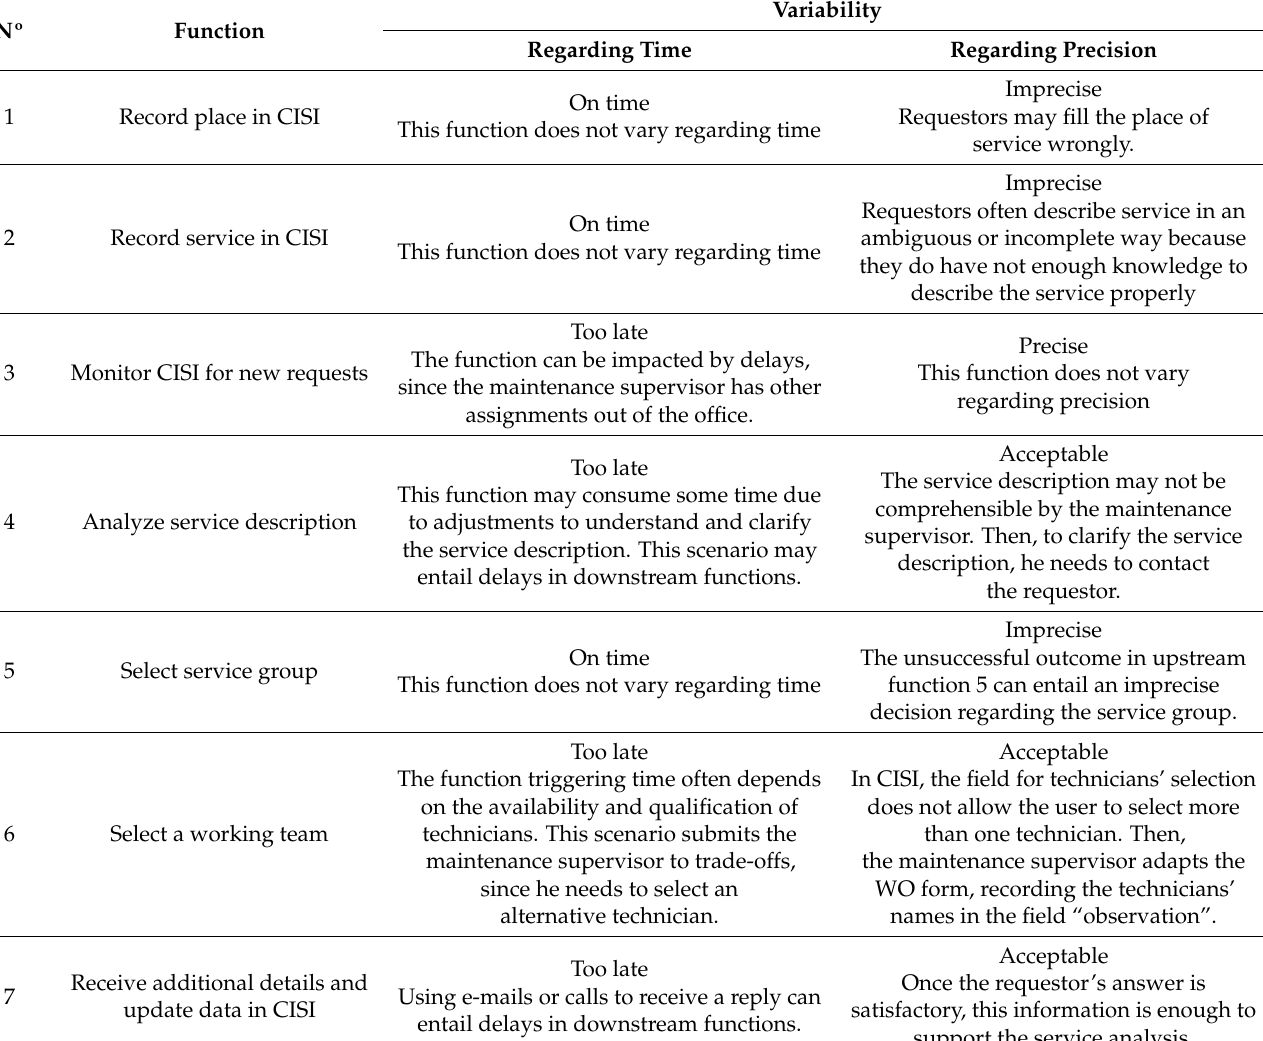
Table 1. Potential variability identified in the work order issuance for the maintenance in HVAC